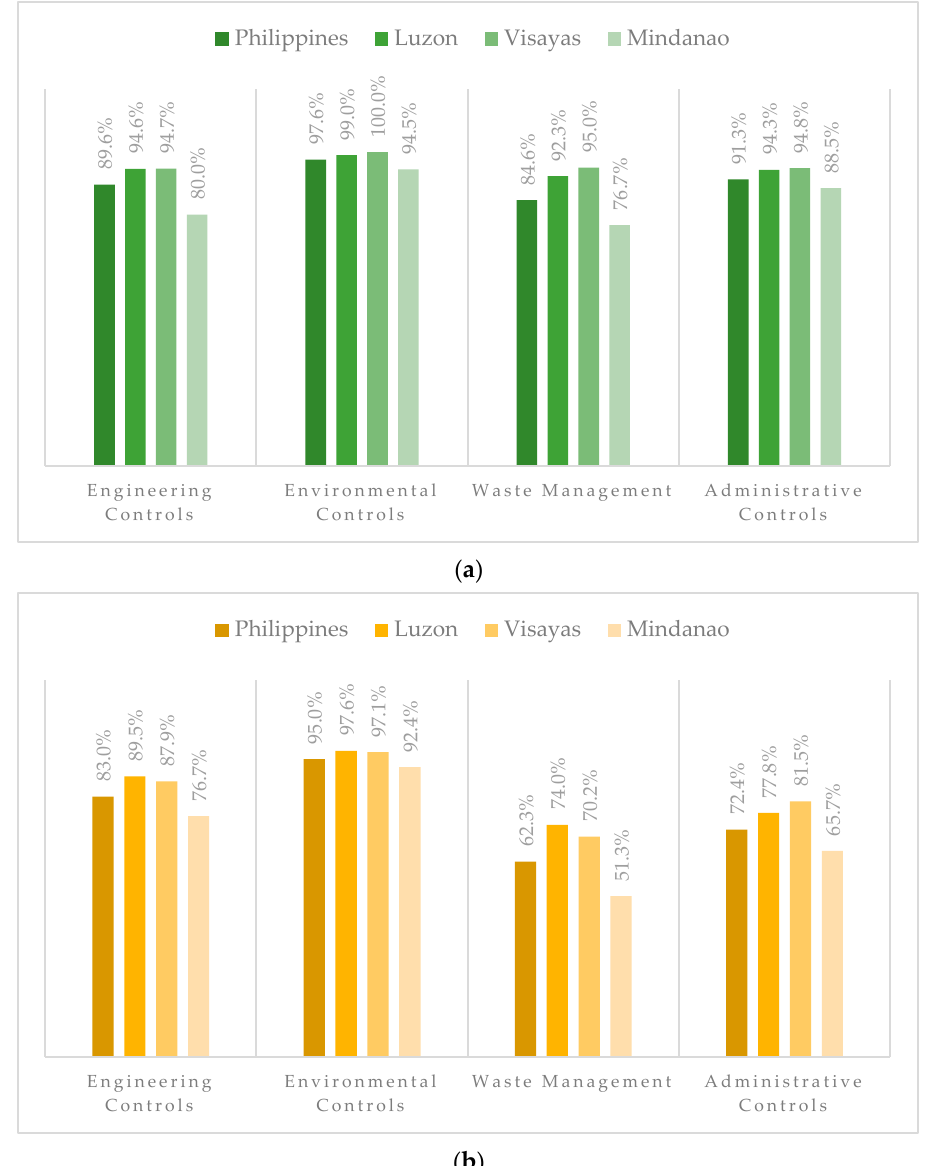
Figure 1. Comparison of IPC compliance between public hospitals and TTMFs across island groups. ( a ) IPC compliance in public hospitals, showing aggregate values per domain; ( b ) IPC compliance in TTMFs, showing aggregate values per domain.